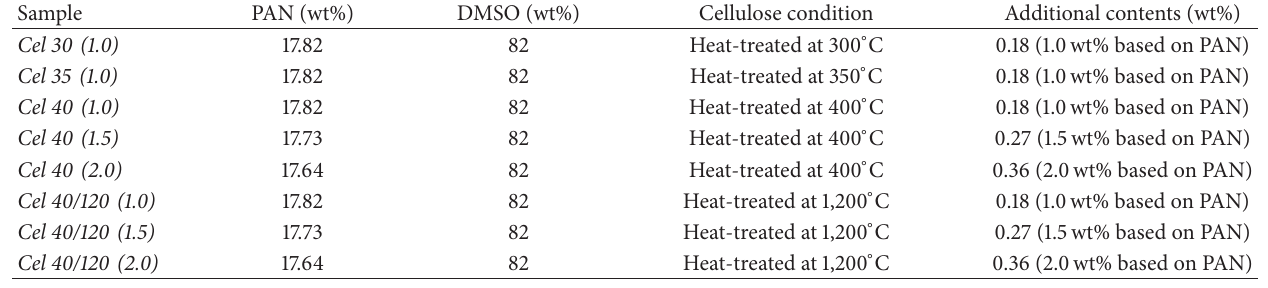
Table 2: PAN-DMSO dope containing heat-treated cellulose particles.